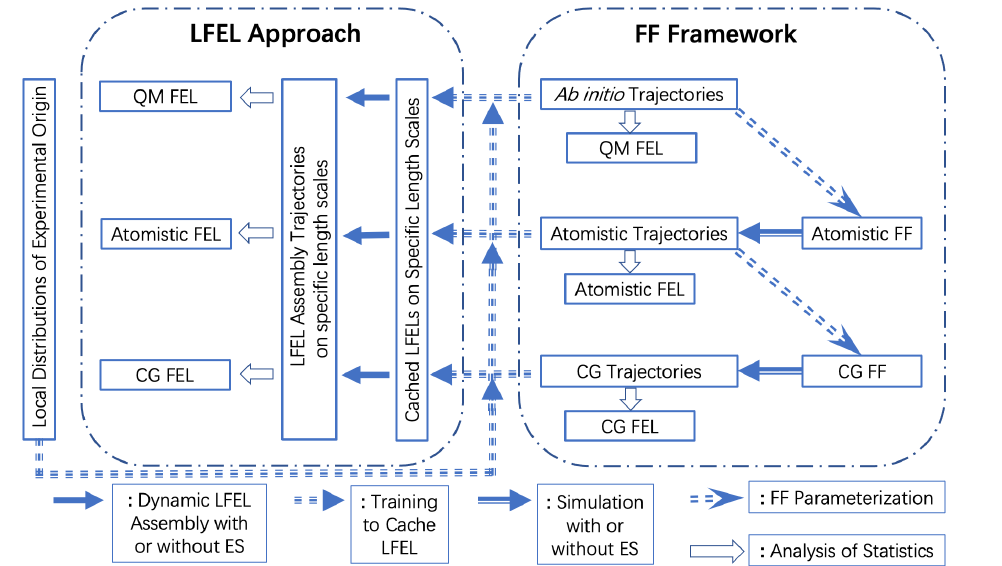
Figure 2. Schematic illustration of the LFEL approach in contrast to present mainstream FF frame- work. FF parameterization is the foundation for present classical computational molecular science.